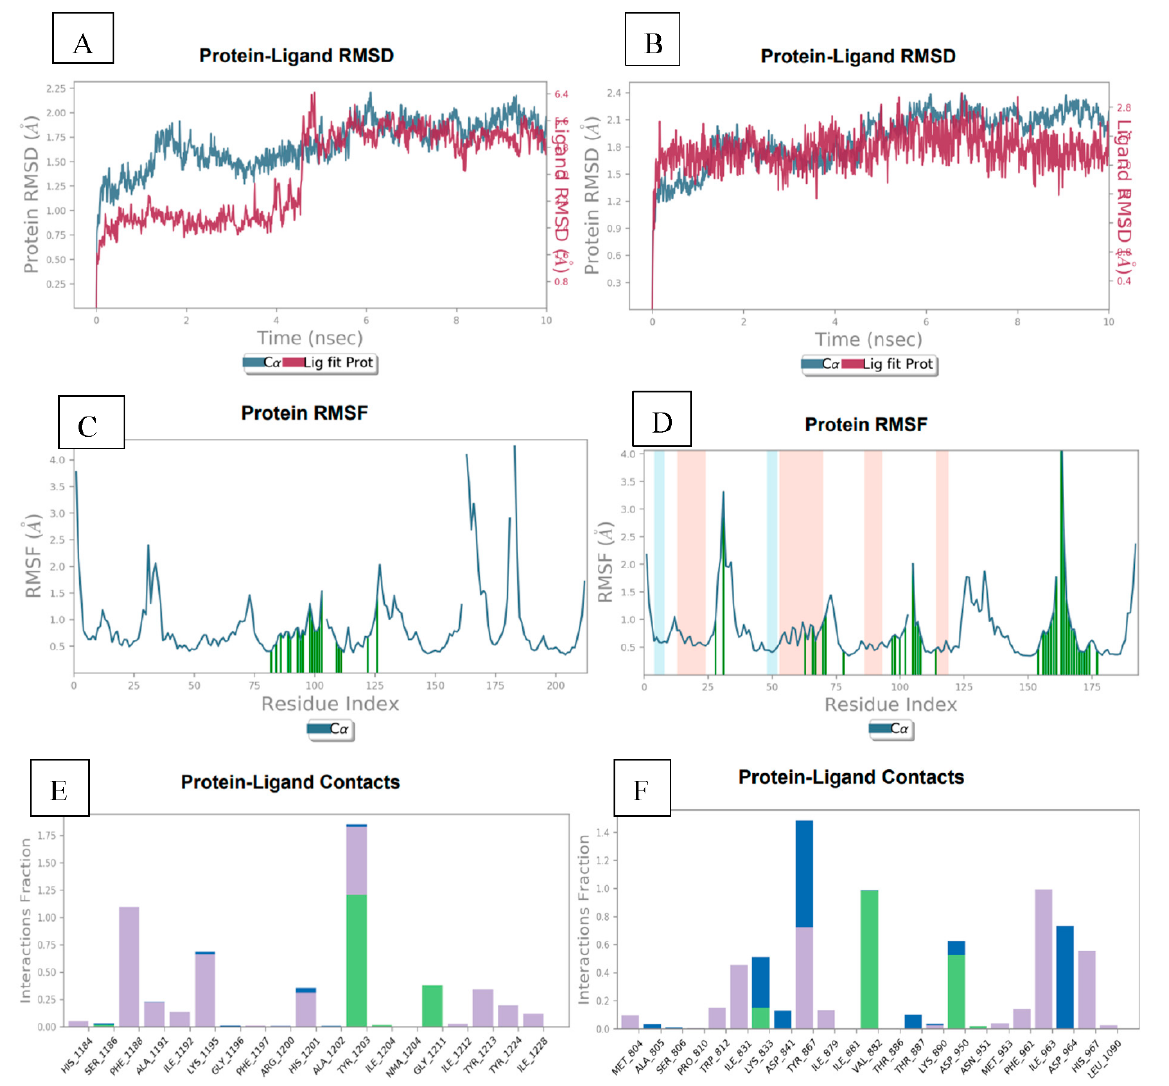
Figure 11. ( A ) Illustration of MD trajectory analysis plots for 4OA7 protein and 14a ligand complex root mean square deviation (RMSD) for backbone atoms. ( B ) Analysis plots for 3L54 protein and 14a ligand complex root mean square deviation (RMSD) for backbone atoms. ( C ) RMSF profile of 4OA7 protein with 14a ligand, representing local changes along the protein chain throughout simulation trajectory. ( D ) RMSF profile of3L54 protein with 14a ligand, representing local changes along the protein chain throughout simulation trajectory. ( E ) Plot representing protein–ligand interaction of 14a with different residues of 4OA7 throughout simulation trajectory. ( F ) Protein–ligand interaction of 14a with different residues of 3L54 throughout simulation trajectory.